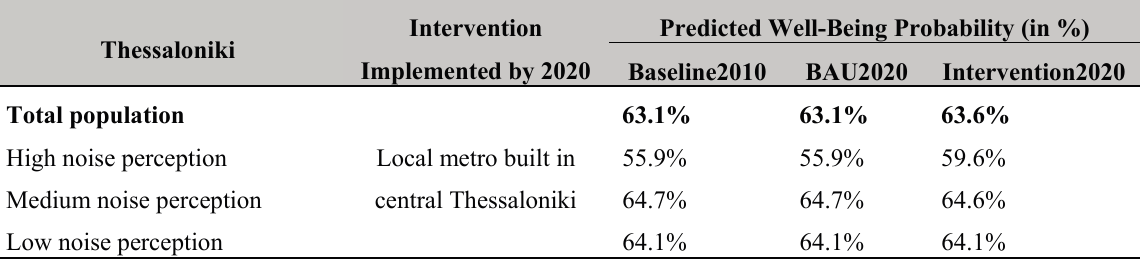
Table 9. Well-being probability in Thessaloniki by noise